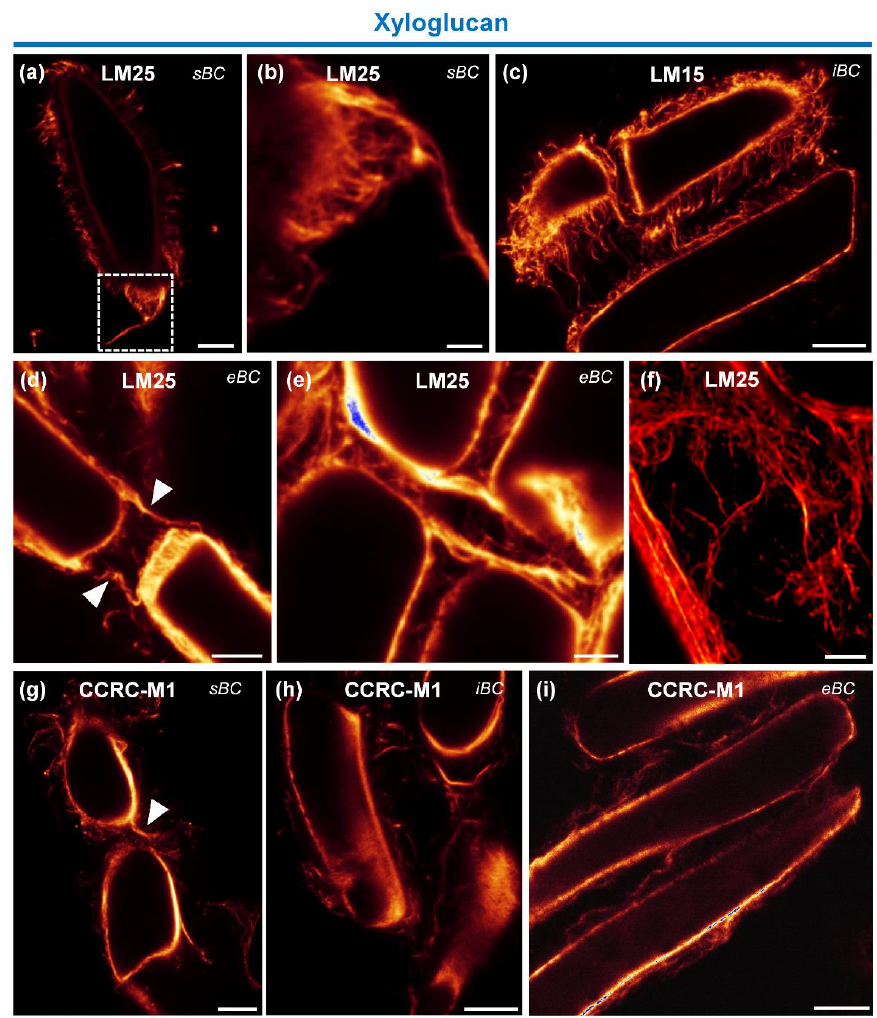
Figure 5. Immunolocalization of xyloglucan epitopes. ( a – h ) Immunofluorescence images showing labeling of the cell wall and extracellular material in all BC morphotypes with ( a , b , d – f ) the mAbs LM25; ( c ) LM15; and ( g – i ) CCRC-M1. Fluorescence labeling appears as a dense fibrous network surrounding the cells and sometimes connecting them together (arrowheads). ( a – c ) Fibrous structures appear to peel off the cell surface and form condensed threads. ( f ) Deconvolution analysis of samples labeled with LM25 in which the network appears even denser between cells. sBC, spherical border cells; iBC, intermediate border cells; eBC, elongated border cells. Scale bars: ( a , c , g – i ) 10 µ m; ( d ) 7.5 µ m; ( e ) 5 µ m; and ( b , f ) 2.5 µ